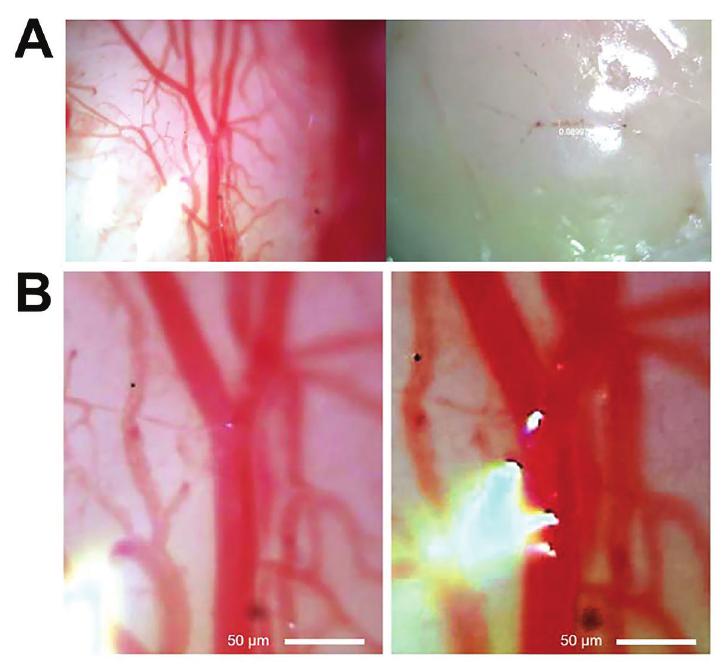
Figure 2. Microscopy of brain cortex after ischemia. A , the left panel shows good cerebral perfusion before ischemia, whereas the right panel exhibits a pale appearance after ischemia- induced blood fl ow blocking, indicating poor perfusion. B , the left panel shows normal blood vessel of the cerebral cortex, whereas the right panel exhibits blood vessel dilation, indicating the presence of hypercapnia and hypotension. Scale bar=50 m